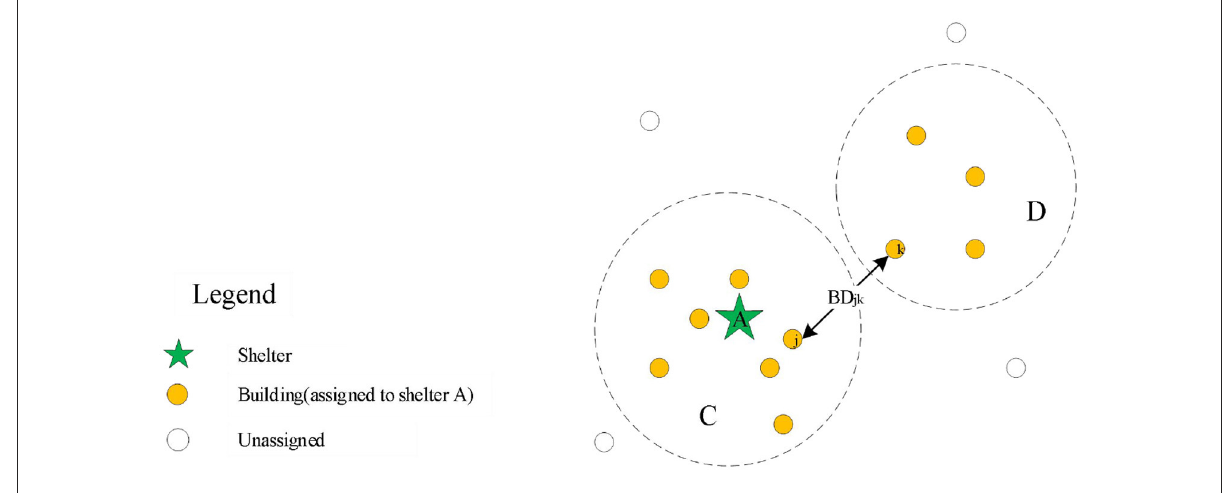
FIGURE1 The scenario analysis of discrete allocation result.